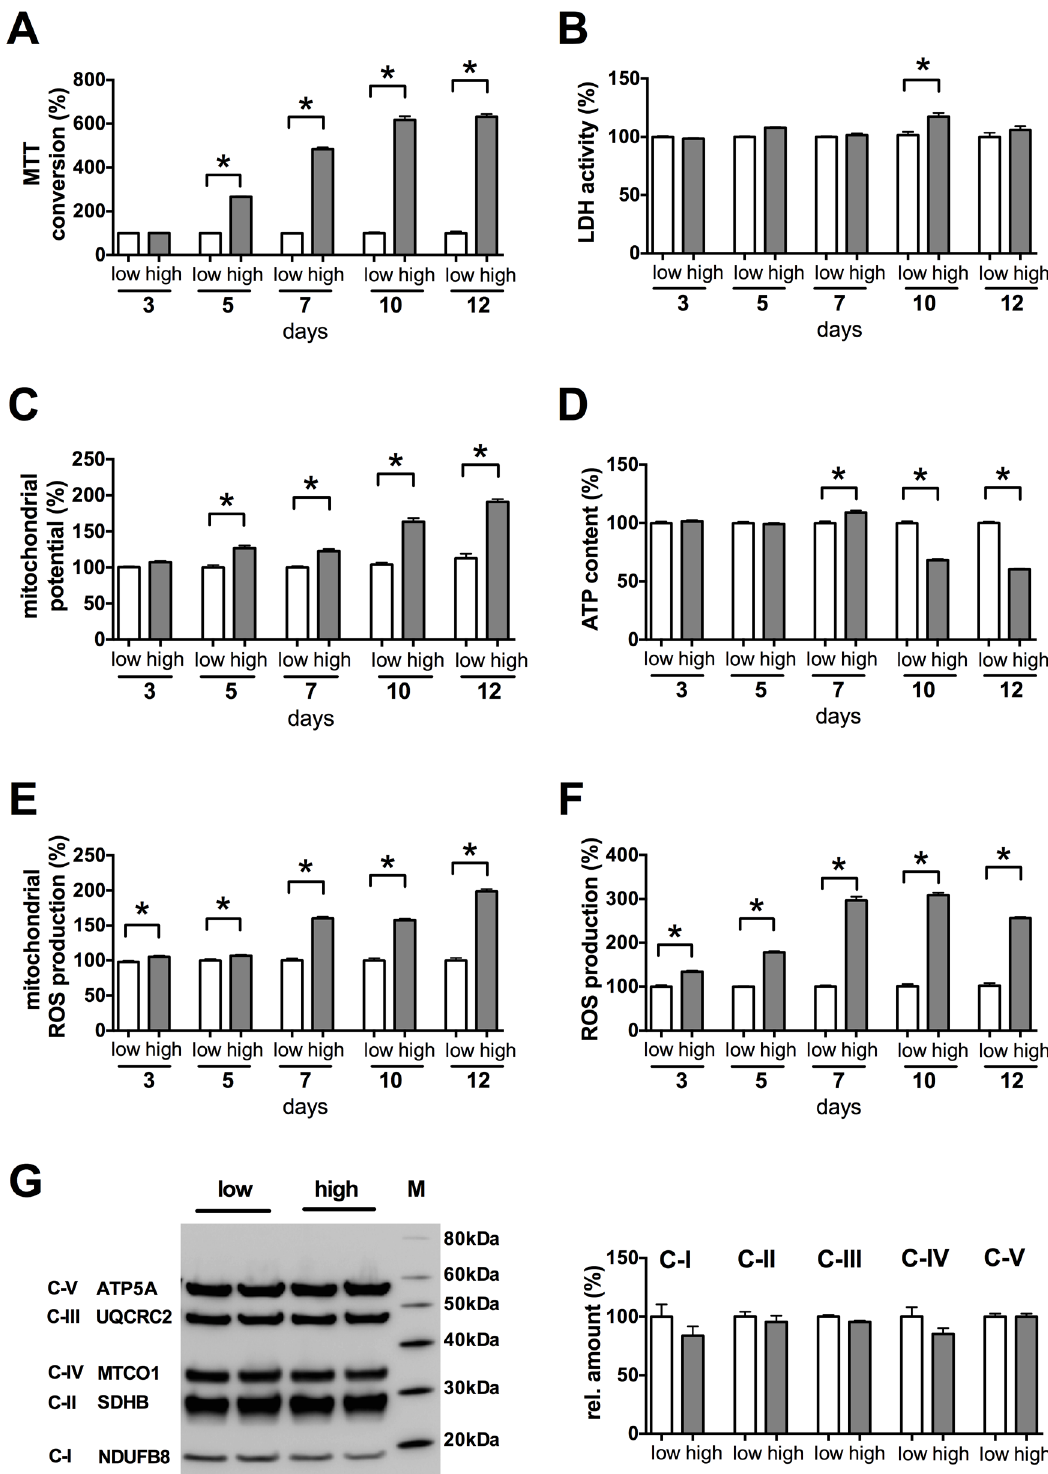
Fig 1. High glucose exposure induces mitochondrial hyperpolarization and oxidant production in b.End3 microvascular endothelial cells. A-F: Confluent b.End3 endothelial cells were maintained in low or high-glucose containing medium for 3 – 12 days and metabolic indices and ROS production were determined. A: The